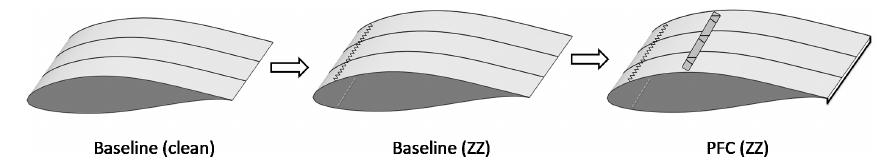
Figure 14. Retrofit application of passive flow control devices on a generic rotor blade section.